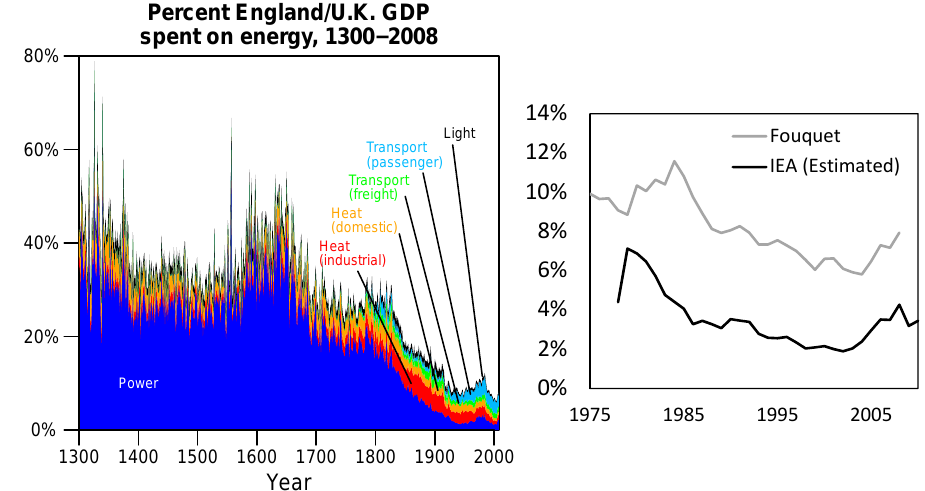
Figure 1. The plot represents f e ,GDP for purchasing energy for services of industrial power, industrial heating, domestic heating, freight transport, passenger transport, and lighting. England and UK data come from Roger Fouquet [57]. IEA estimated f e ,GDP come from King et al.